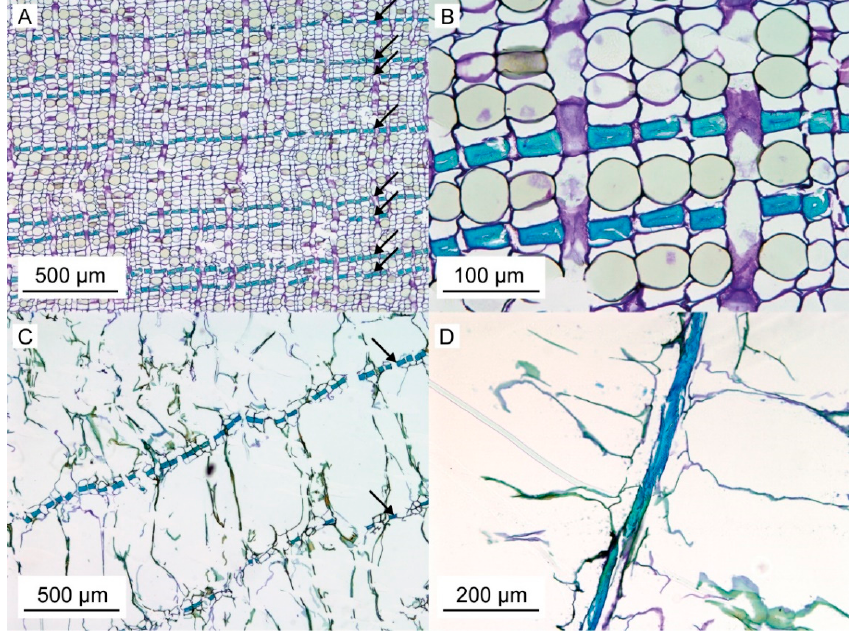
Figure 3. S. giganteum bark sections stained with toluidine blue. ( A ) Cross-section of the inner bark, already revealing layers of highly lignified, thick-walled fiber cells arranged in rows (stained blue, see arrows) located between thin-walled parenchymatous cells. ( B ) Enlarged view of a cross-section of the inner bark showing the nearly rectangular cross-section of the thick-walled fibers. ( C ) Cross-section of the outer bark with the largely intact thick-walled fibers still arranged in layers (arrows). As in the inner bark, many of these intact fibers might be interconnected via the short side of their cross-section, whereas the thin-walled parenchymatous cells between them are ruptured. ( D ) The fibrous nature of these thick-walled and elongated cells (stained blue) is visible in radial sections of the outer bark.